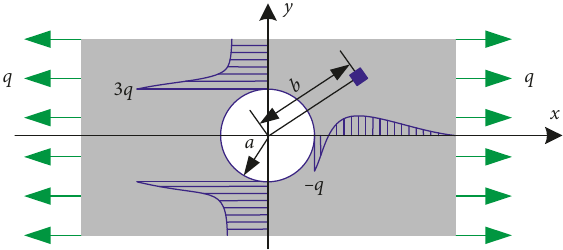
Figure 4: Hoop principal stress variation tendency with b . Table 1: Hoop principal stress of y -axis at several specific distances.